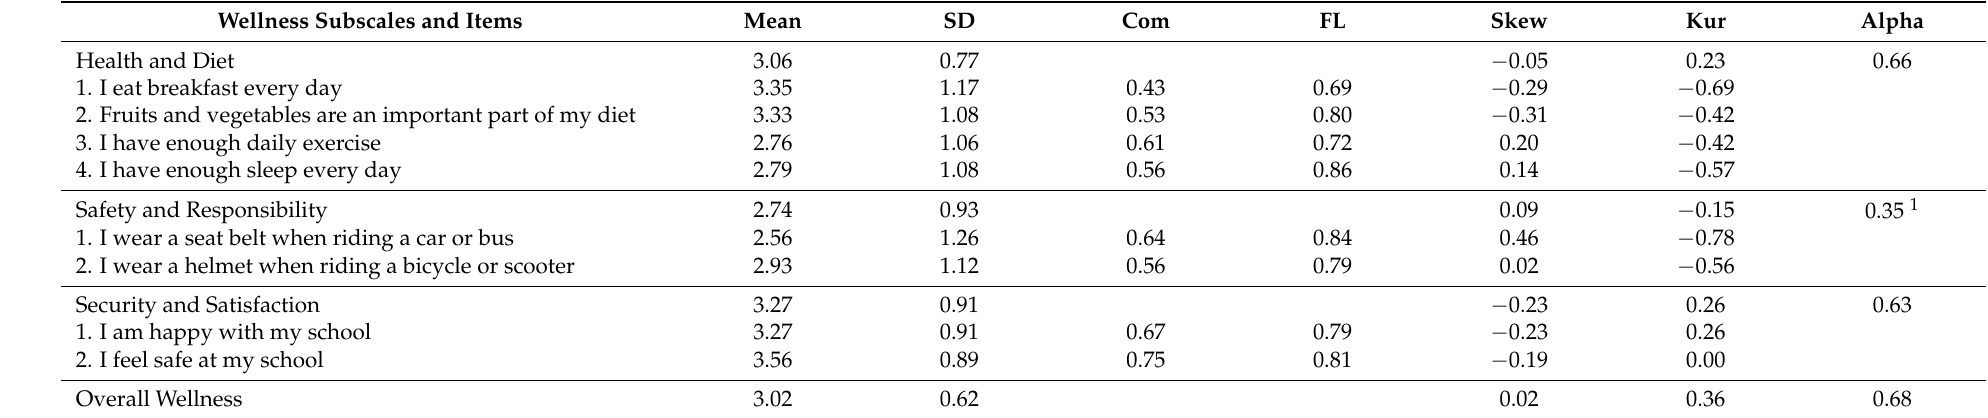
Table 9. Descriptive statistics, communalities, factor loadings, and alpha reliabilities of